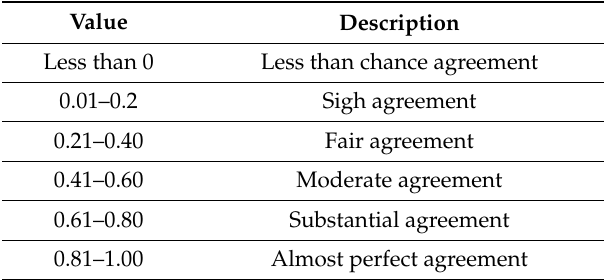
Table 2. Interpretation of Kappa